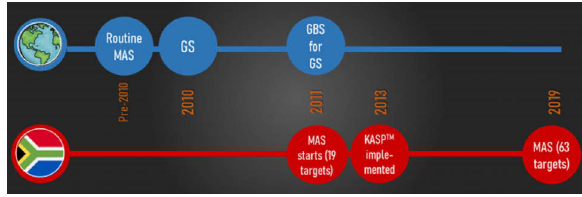
Figure 6: Timeline of MAS in South Africa (bottom) compared to international programmes